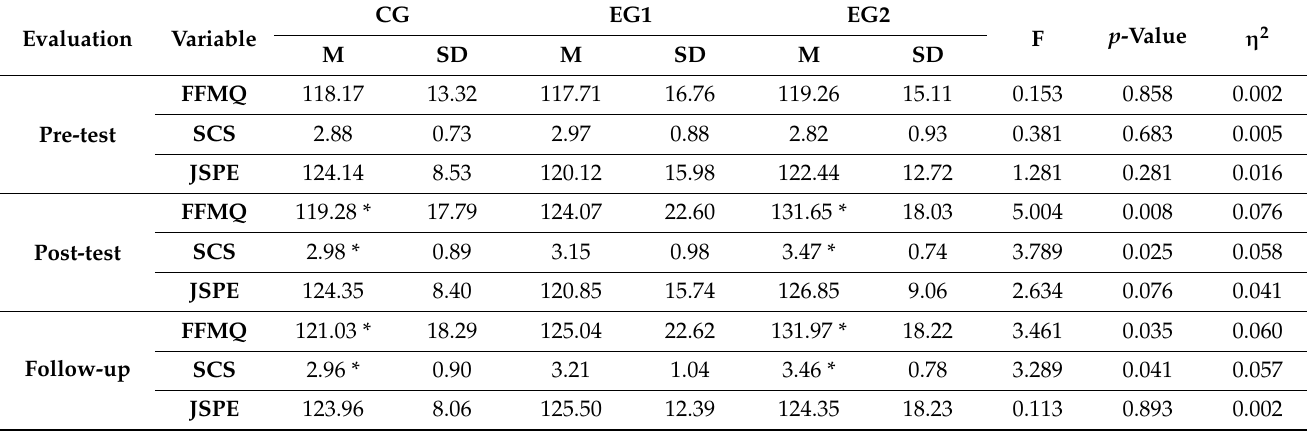
Table 2. Comparison of FFQM, SCS, and JSPE according to the type of group using one-way ANOVA. Evaluation